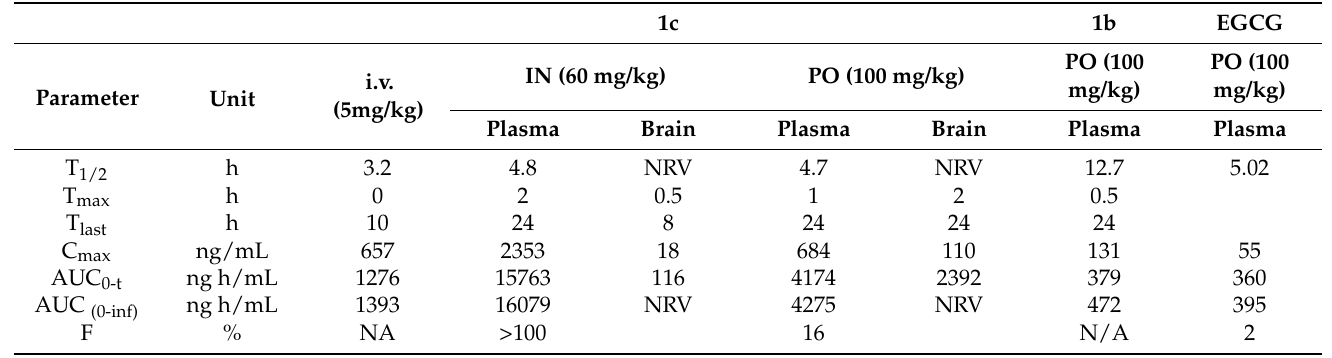
Table 2. Summary of pharmacokinetic